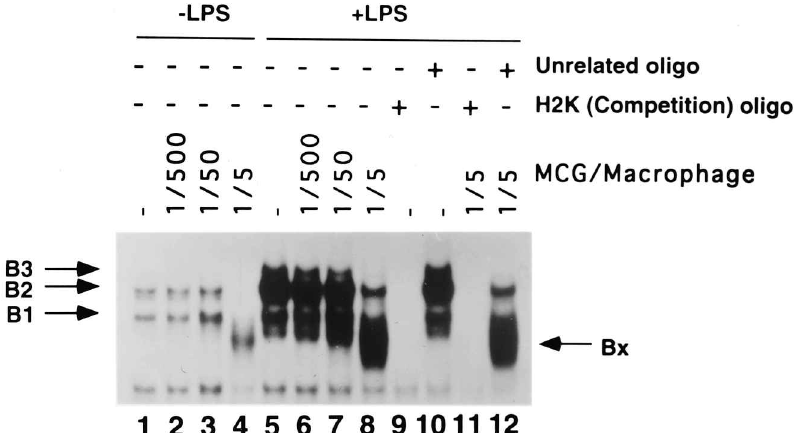
FIG. 1. Effect of MCG exposure on NF- k B proteins in J774 cells. J774 cells were incubated for 1h at 37°C without MCG (lanes 1, 5, 9 and 10) or with MCG (lanes 2 to 4, 6 to 8, 11 and 12) at J774 cells to mast cell ratios of 500 to 1 (lanes 2 and 6), 50 to 1 (lanes 3 and 7) or 5 to 1 (lanes 4, 8, 11 and 12). They were further incubated for 30min at 37°C without (lanes 1 to 4) or with LPS (10ng/ml) (lanes 5 to 12). The nuclear proteins extracted from the cells were incubated with [ 32 P]-labeled HIV NF- k B motif- containing oligonucleotide in the absence (lanes 1 to 8) or presence of 100-fold excess of either competitor H2K b (lanes 9 and 11) or unrelated (lanes 10 and 12) oligonucleotide, and were subjected to EMSA. The autoradiograph shown is the representative of three separate experiments, which gave very similar results.